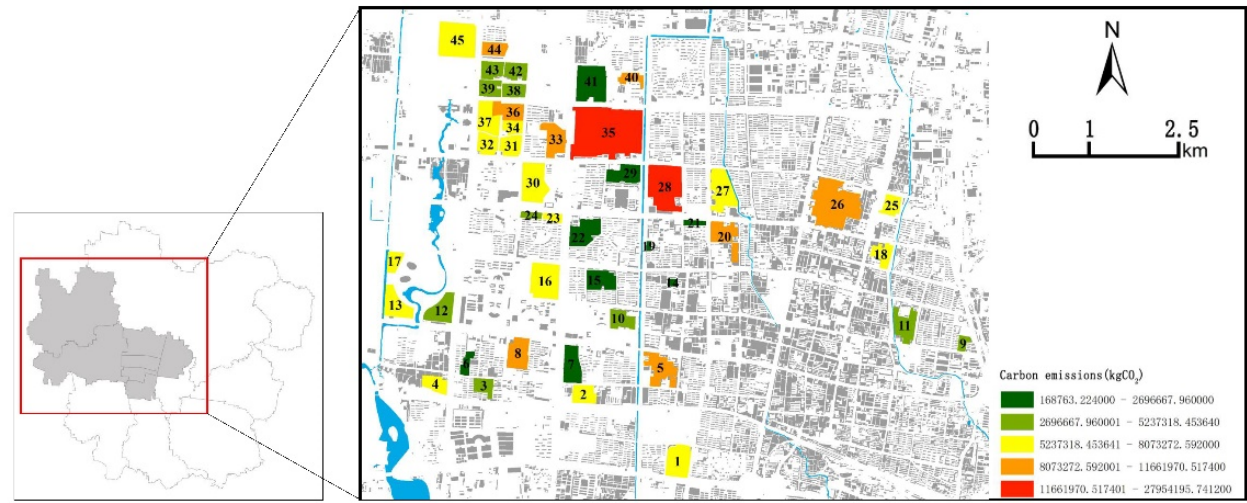
Figure 8. One example of a carbon emissions database.